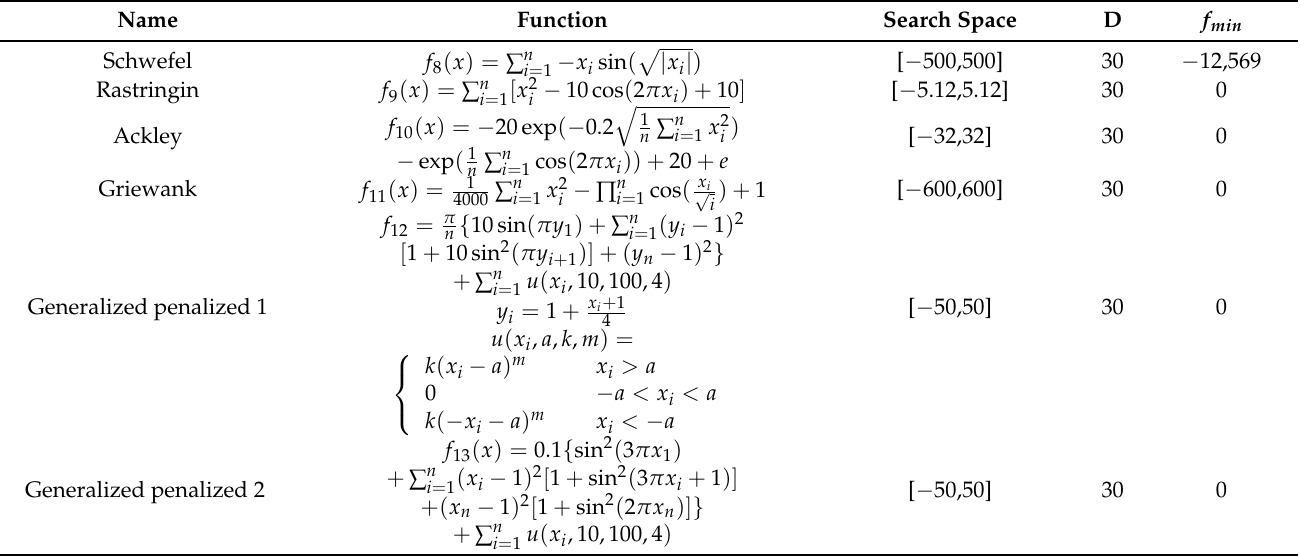
Table 11. Common multimodal benchmark